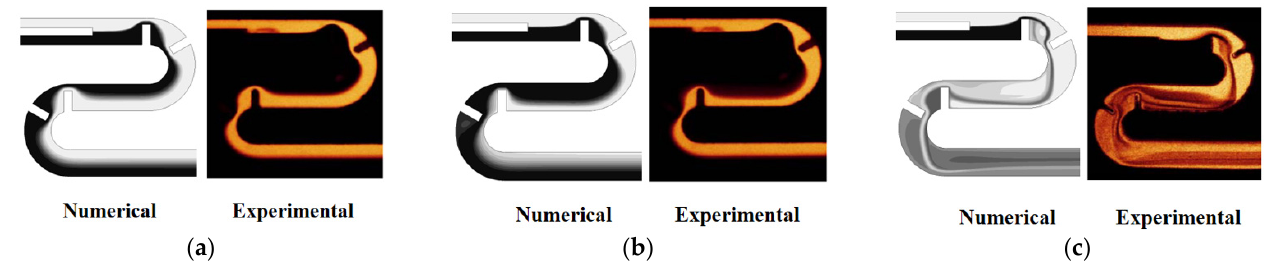
Figure 5. Comparison of numerical concentration distribution with experimental images of Tsai et al. [19]: ( a ) Re = 1, ( b ) Re = 9, and ( c ) Re = 81. Reprinted with permission from [19].